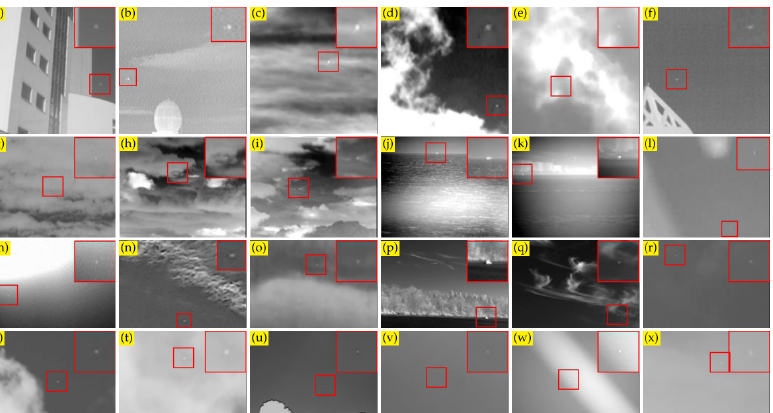
Figure 6. Partial presentation of the SIRST dataset. The images ( a – x ) come from several different scenes and the number of pixels occupied by the target is very small. The small red box in the image is the area where the target is located, and it will be enlarged and displayed in the big red box in the upper right corner.